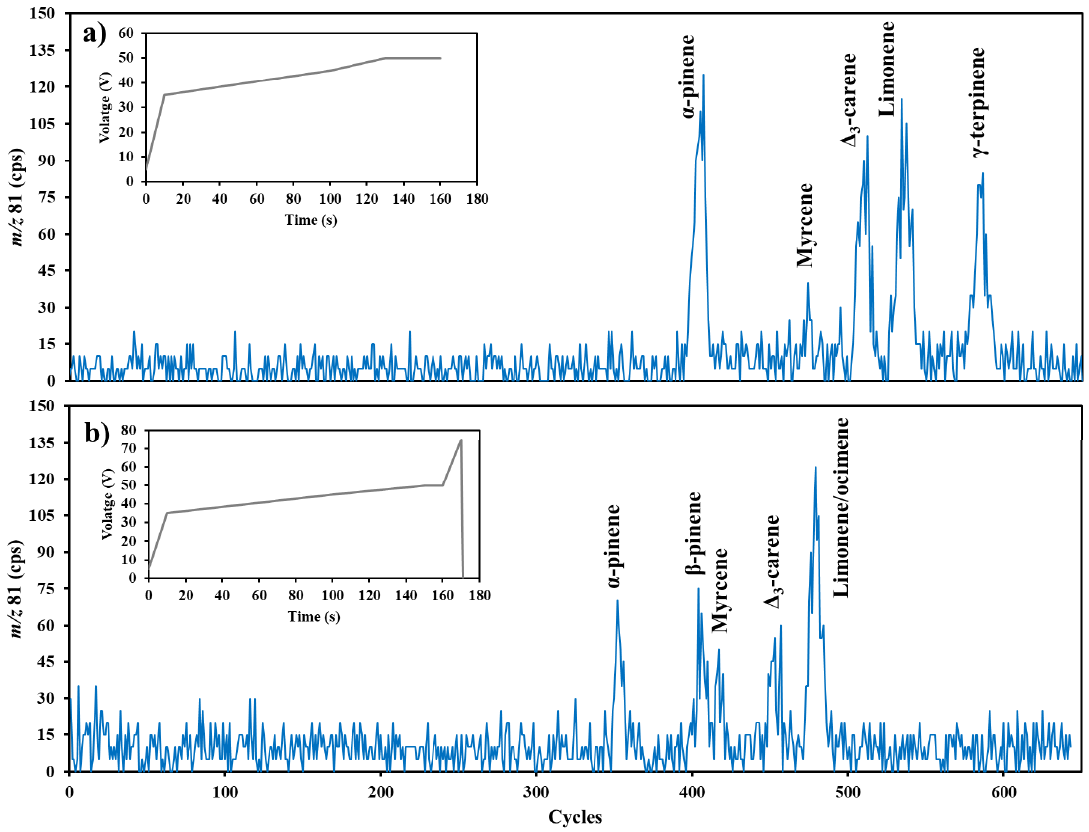
Figure 4. Chromatograms obtained when sampling ( a ) from the homemade MTs gas mixture, using 3 sccm of N 2 as the carrier gas and applying the optimal voltage ramp and ( b ) from the National Physical Laboratory (NPL) gas standard with 4.2 sccm of He as the carrier gas and applying the optimal, extended voltage ramp (Table 1).